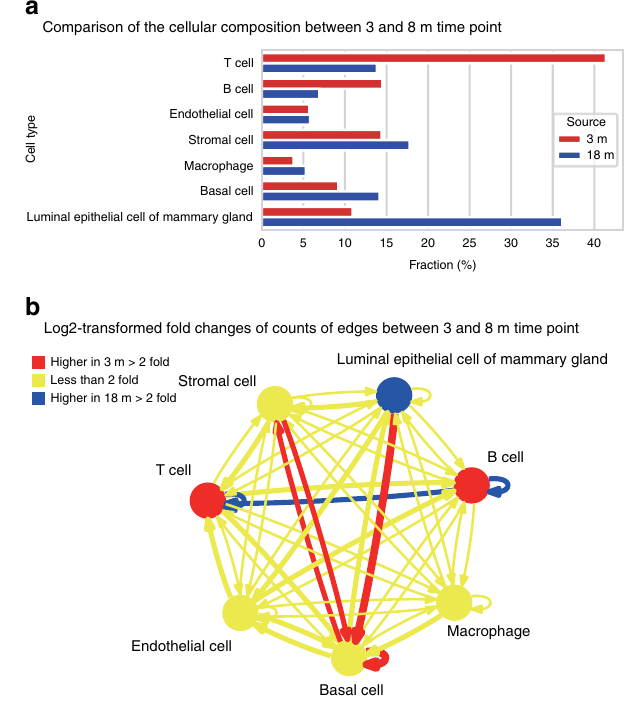
Fig. 6 Differential analysis of cell-connectivity-summary networks from aging mammary gland in Tabula Muris. a Comparison of population fraction of seven cell types in the 3- and 18-month-old murine mammary gland. b Comparison of edge-count-based cell-connectivity-summary networks at two time points. Summary edges with twofold or more active ligand – receptor pairs connecting them at 3 months than 18 months are shown in red while those with twofold or more active ligand – receptor pairs connecting them at 18 months than 3 months are shown in blue. Edge thickness is weighted by the log 2 -transformed fold changes between the two networks. Cell types (nodes) with a twofold difference in cell fraction are shown in red (higher in the 3-month timepoint) and blue (higher in the 18-month